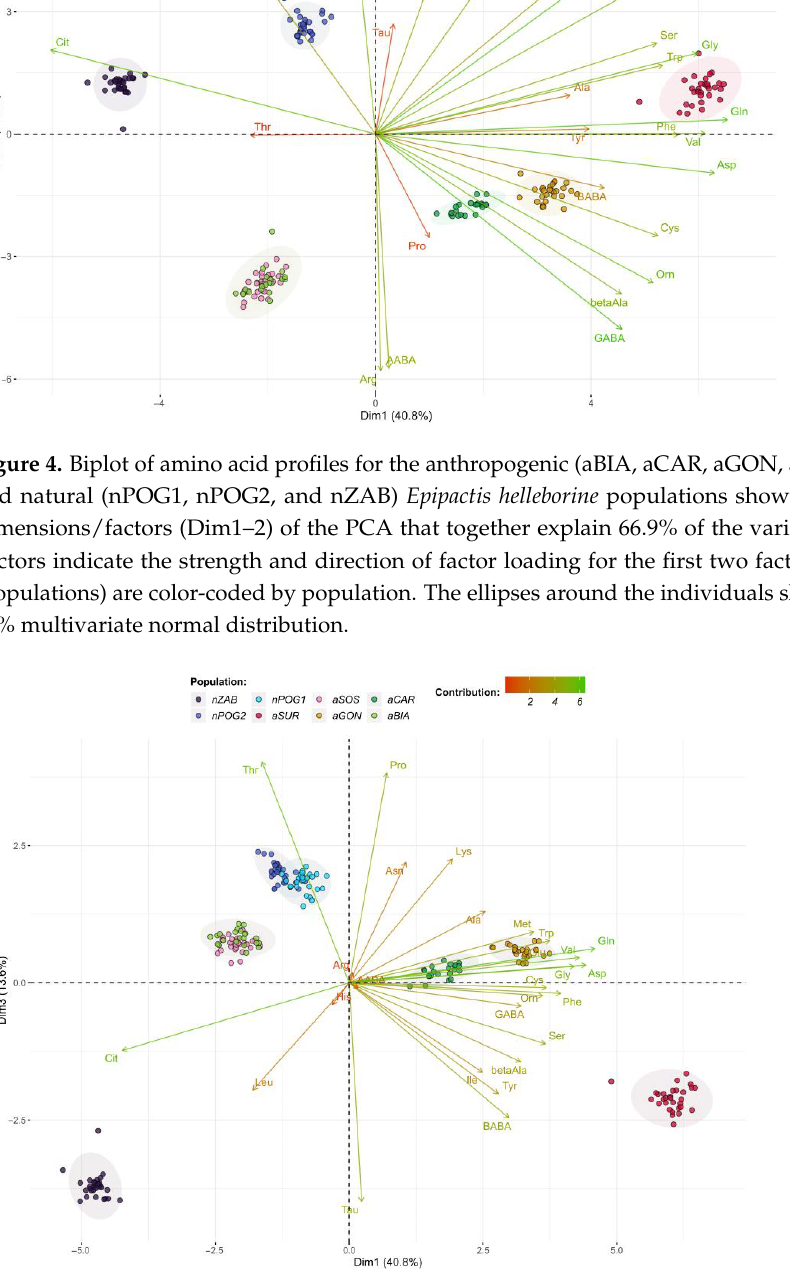
Figure 5. Biplot of amino acid profiles for the anthropogenic (aBIA, aCAR, aGON, aSOS, and aSUR) and natural (nPOG1, nPOG2, and nZAB) Epipactis helleborine populations showing the first two dimensions/factors (Dim1–3) of the PCA that together explain 54.4% of the variance. The biplot vectors indicate the strength and direction of factor loading for the first two factors. Individuals (populations) are color-coded by population. The ellipses around the individuals show an assumed 95% multivariate normal